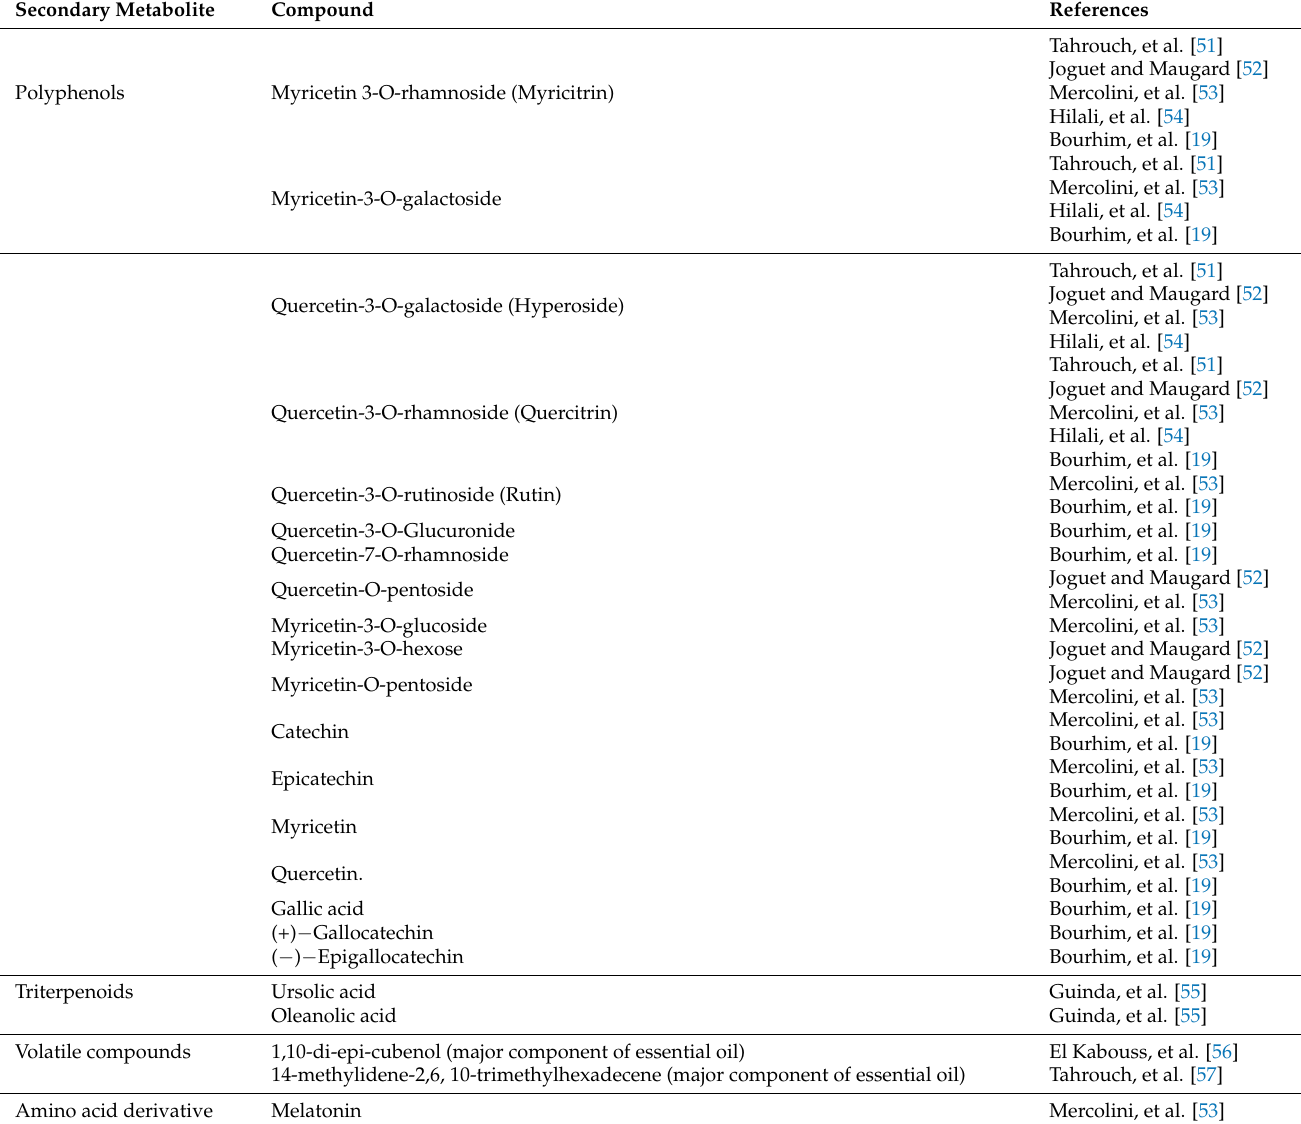
Table 2. Secondary metabolites of argan